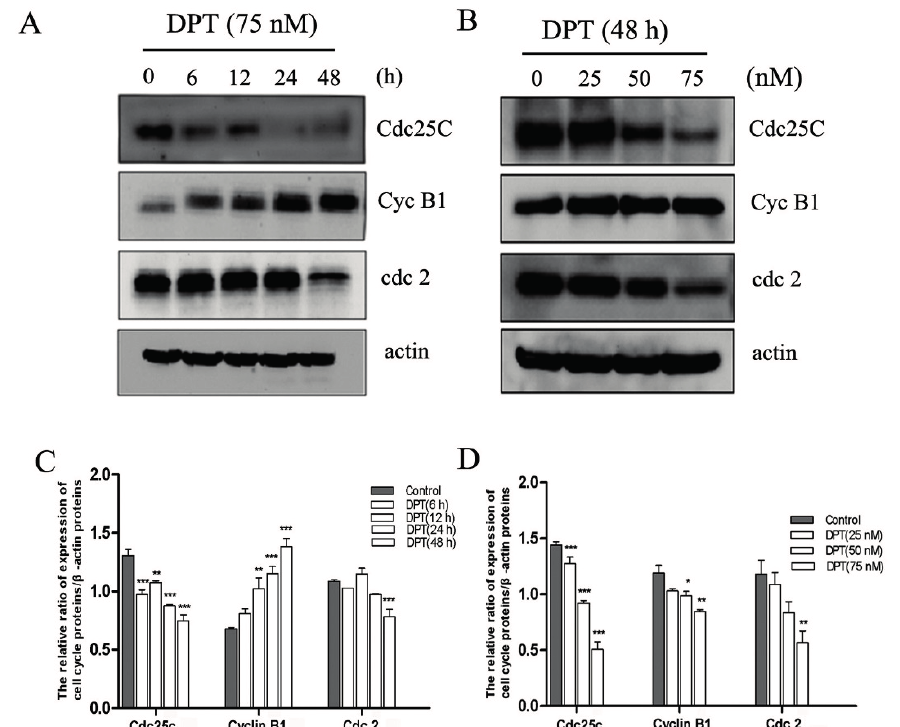
Figure 5. Effects of DPT on cell cycle regulatory proteins in SGC-7901 cells. The levels of cell cycle-related proteins including Cdc25C, cyclin B1 and Cdc2 were assessed by western blot analysis. ( A ) Cells were treated with DPT (75 nM) for the indicated time courses. ( B ) Cells were treated with different concentrations of DPT for 48 h. ( C , D ) Statistical analysis of cell cycle arrest relating-proteins. Data are presented as means ± SD of three independent tests. * p < 0.05 versus control, ** p < 0.01 versus control, *** p < 0.001 versus